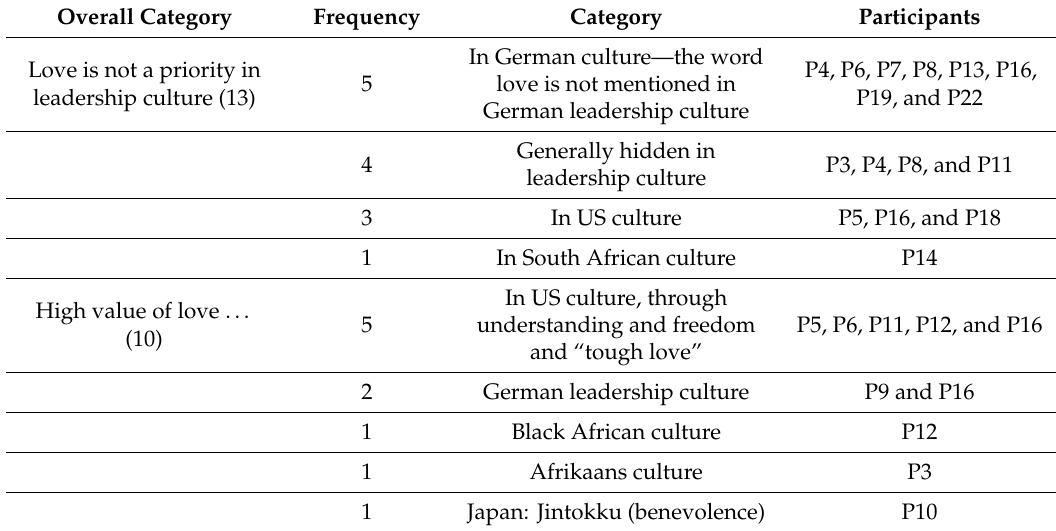
Table 6. Love in leadership